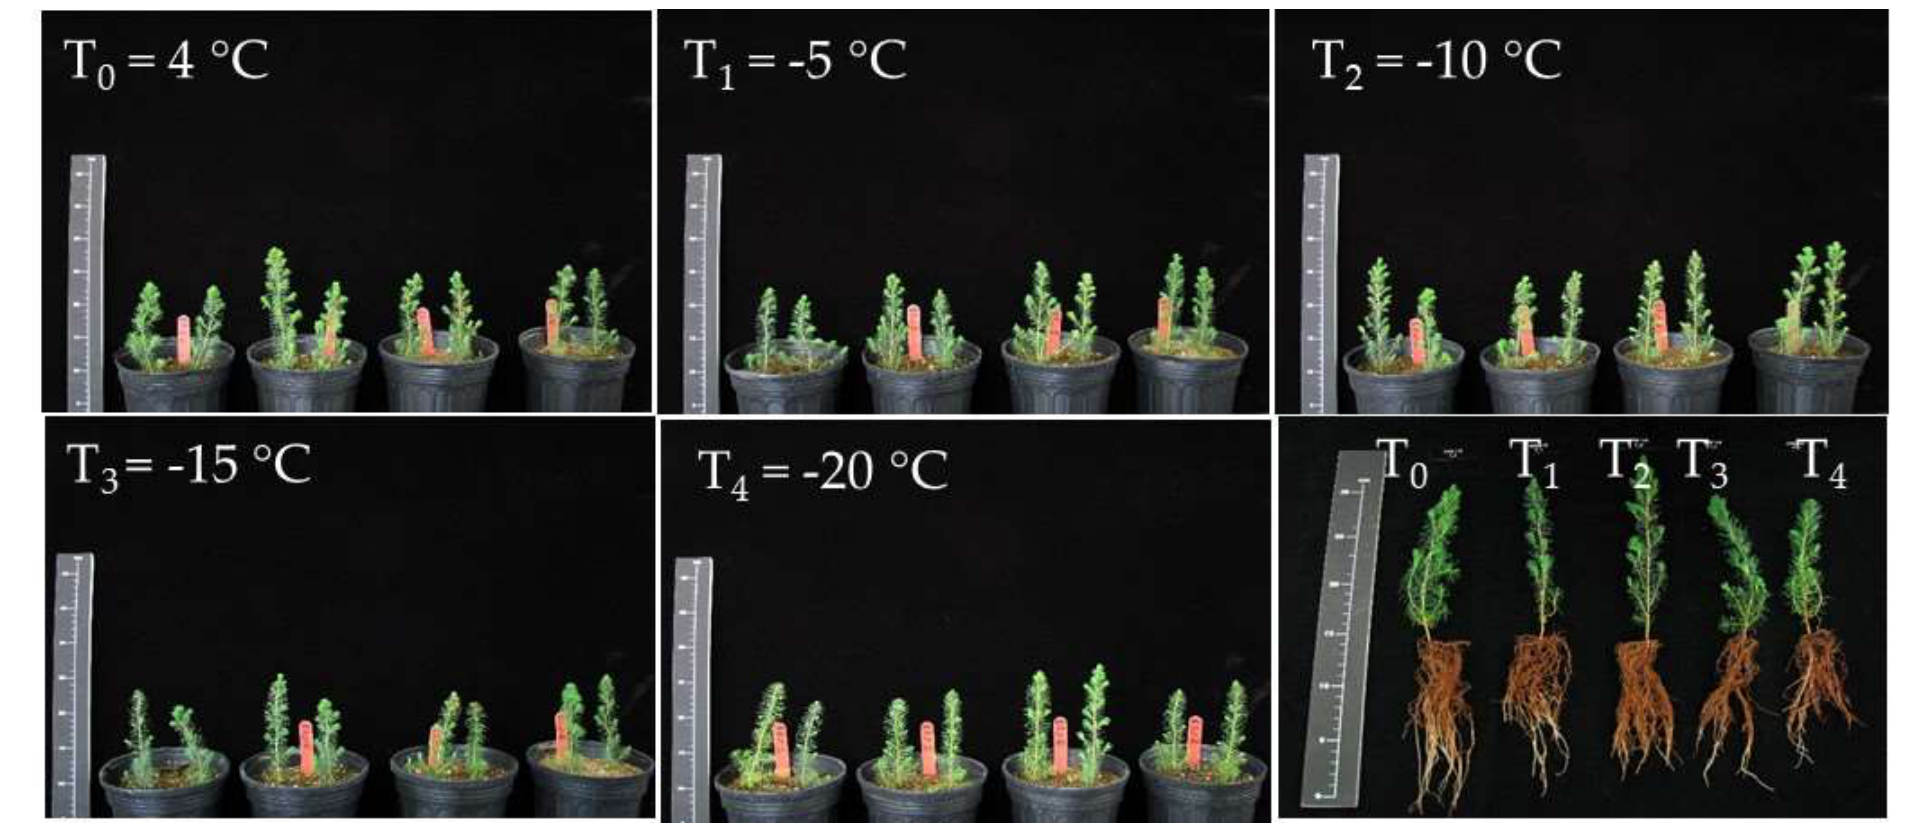
Figure 3. Bud burst of all buds of main stems and lateral branches of all black spruce (1 + 0) seedlings in response to different temperatures (T 0 , T 1 , T 2 , T 3 , and T 4 ) and after 21 days of growth during the recovery period under optimal greenhouse growing conditions. Example of new root initiation in response to the same temperatures and optimal growing conditions.